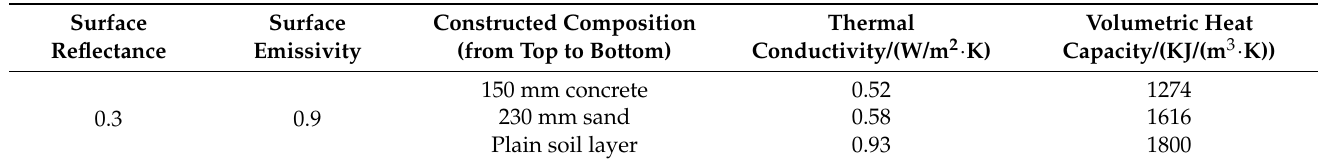
Table 6. Ground parameter